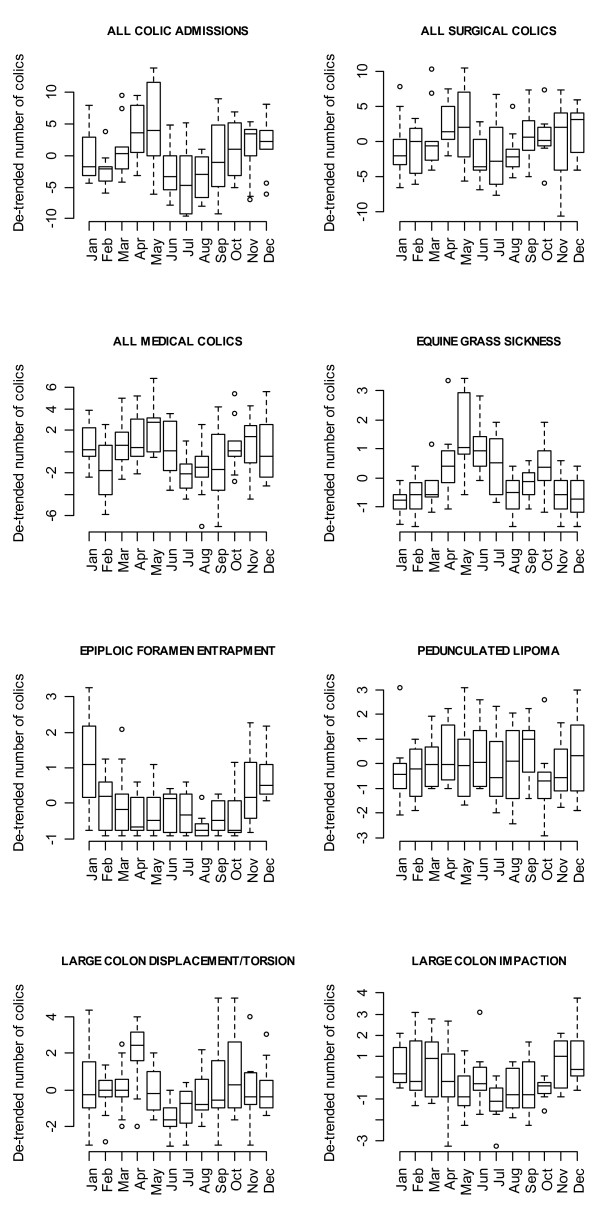
Boxplots of de-trended (annual average subtracted) colic admissions by month for each colic admitted to a UK referral hospital between January 1995 – December 2004.